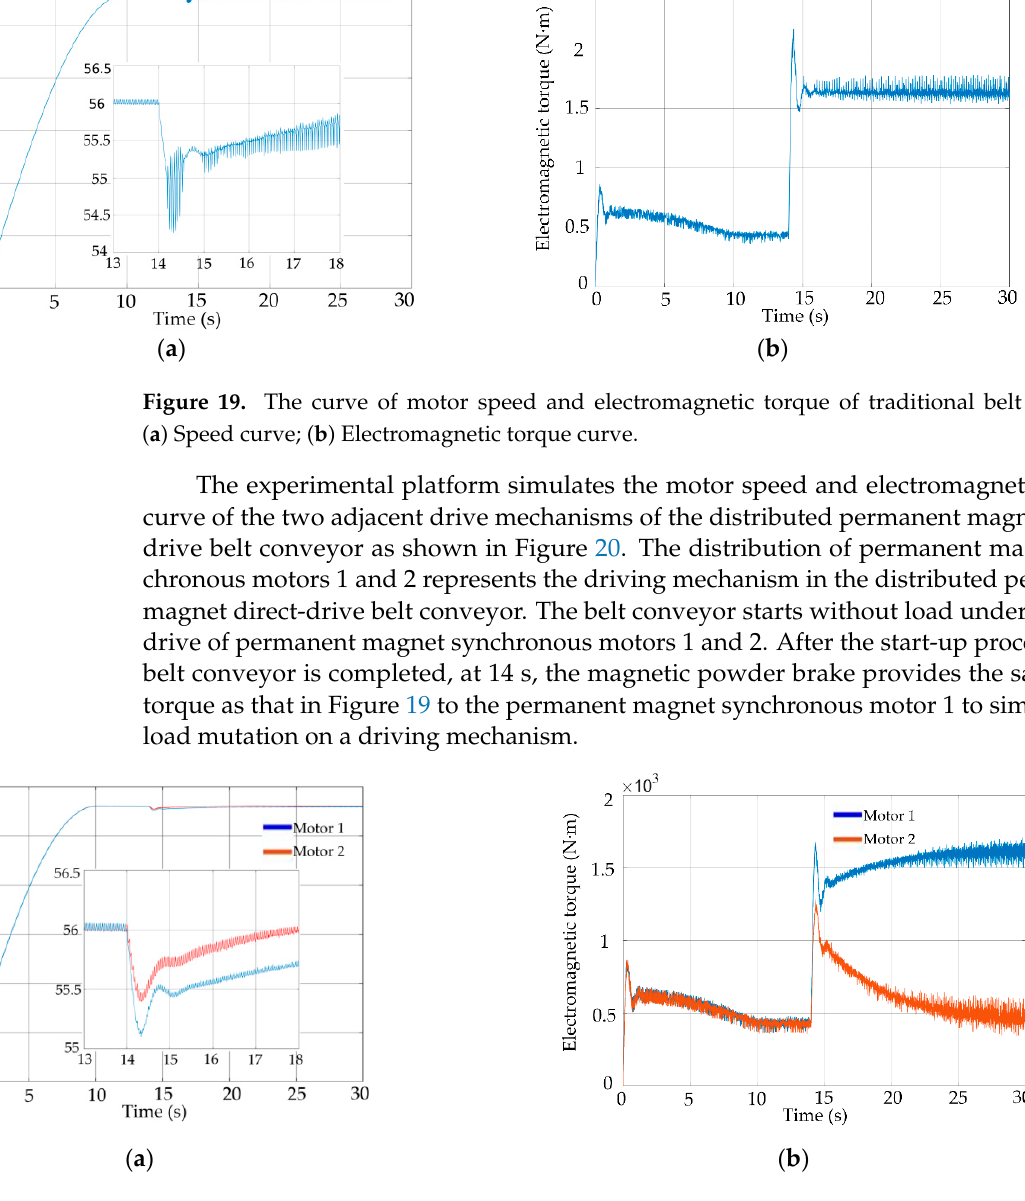
Figure 20. The curves of motor speed and electromagnetic torque of two adjacent driving mechanisms of distributed permanent magnet direct-drive belt conveyor. ( a ) Speed curve; ( b ) Electromagnetic torque curve.